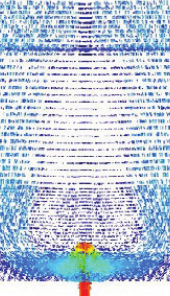
Figure 12: Velocity vector field on upstream water